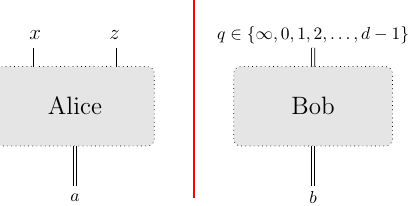
FIG. 10. Schematic of the nonlocal Torpedo Game: Alice and Bob are spacelike separated. Alice receives dits x and z . Bob is asked a question q ∈ {∞ , 0, . . . , d − 1 } and outputs c , which should satisfy the winning conditions given by w q ( x , z ) with high probability. In the quantum version, they may share a maximally entangled state composed of a d -dimensional quantum state for each